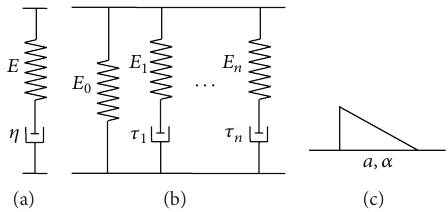
Figure 1: Maxwell model (a); generalized Maxwell model (b); Scott- Blair element or springpot